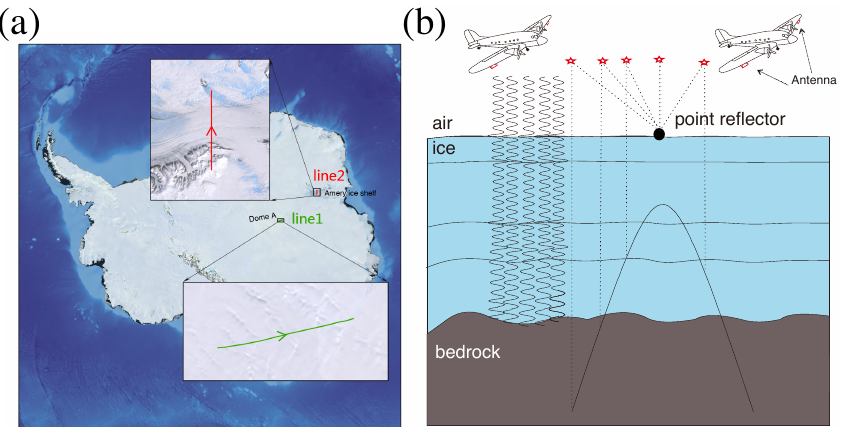
Figure 1. ( a ) Locations of the two selected airborne IPR data. Line 1 (green line) is part of the line named TSH_TRV01b (abbr. TSH), which was collected during CHINARE 32 (2015/2016), and Line 2 (red line), named AMY_Y335a (abbr. AMY), was collected during CHINARE 34 (2017/2018). The vectors in the green line and red line indicate the directions of the flights. ( b ) Schematic airborne IPR transect showing the resultant radar waves and a hyperbola geometry for a strong point reflector. Red stars indicate the position of the